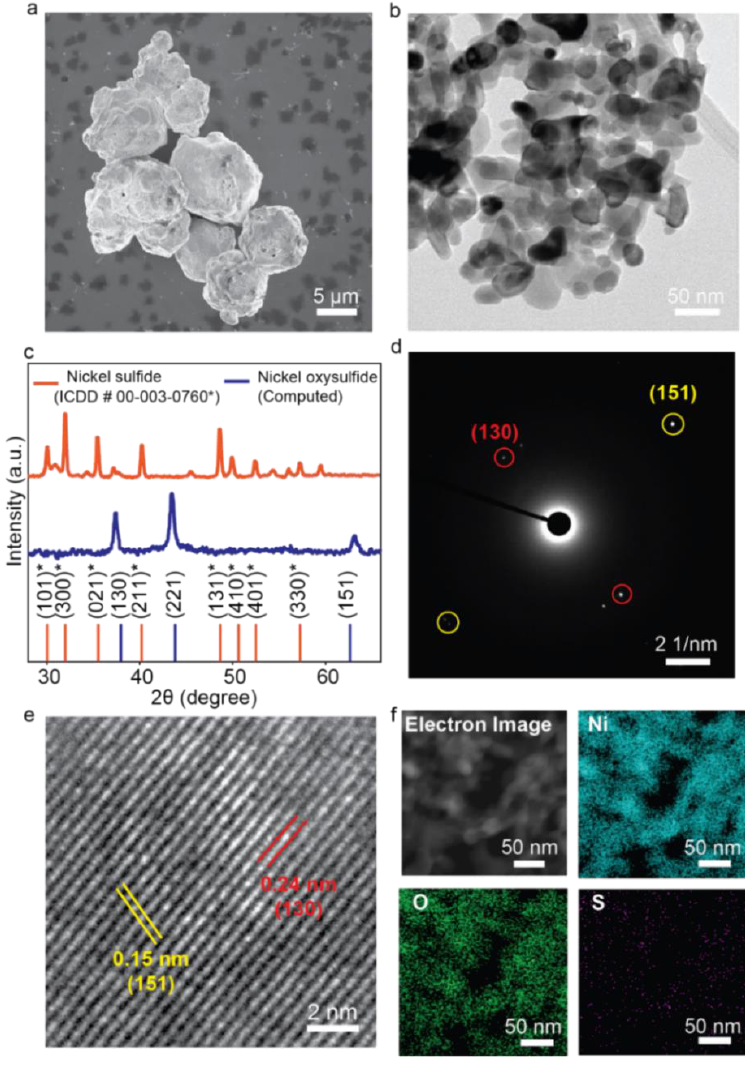
Figure 1. Material characterizations for nickel oxysulfide in ( a ) SEM, ( b ) TEM, ( c ) XRD measures for both nickel sulfide (indexed by ICDD # 00-003-0760; the corresponding crystal planes suffixed with ‘*’) and nickel oxysulfide (the crystal planes simulated from NiSO 4 crystal model, space group Cmcm, a = 5.199 Å, b = 7.956 Å and c = 6.446 Å), ( d ) SAED, ( e ) HRTEM and ( f ) EDS